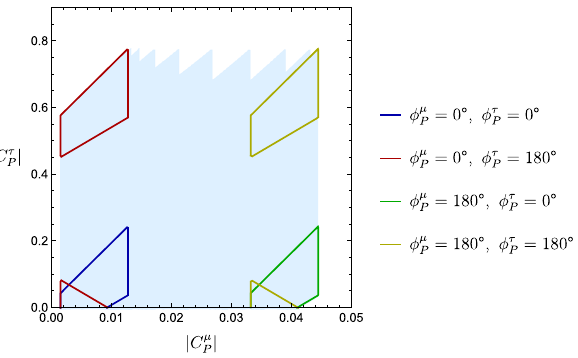
μ | – | C τ | plane obtained from the overlap Fig. 15 Region in the | C P P μ between the contours following from R τ μ and R (cid:3) e ,μ (cid:4); ρ [ q 2 ≤ 12 ] GeV 2 μ μ and vary the phases φ and φ τ independently in the interval [ 0 ◦ , 180 ◦ ] , P P giving the blue background region. The jagged upper boundary is due μ to varying φ in steps of 20 ◦ . The coloured regions indicate solutions P μ ,φ τ ∈ { 0 ◦ , 180 ◦ } obtained for φ P P